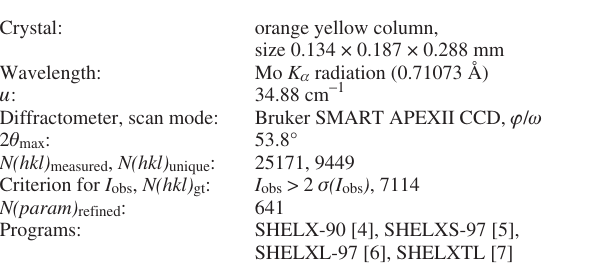
Table 1. Data collection and handling.